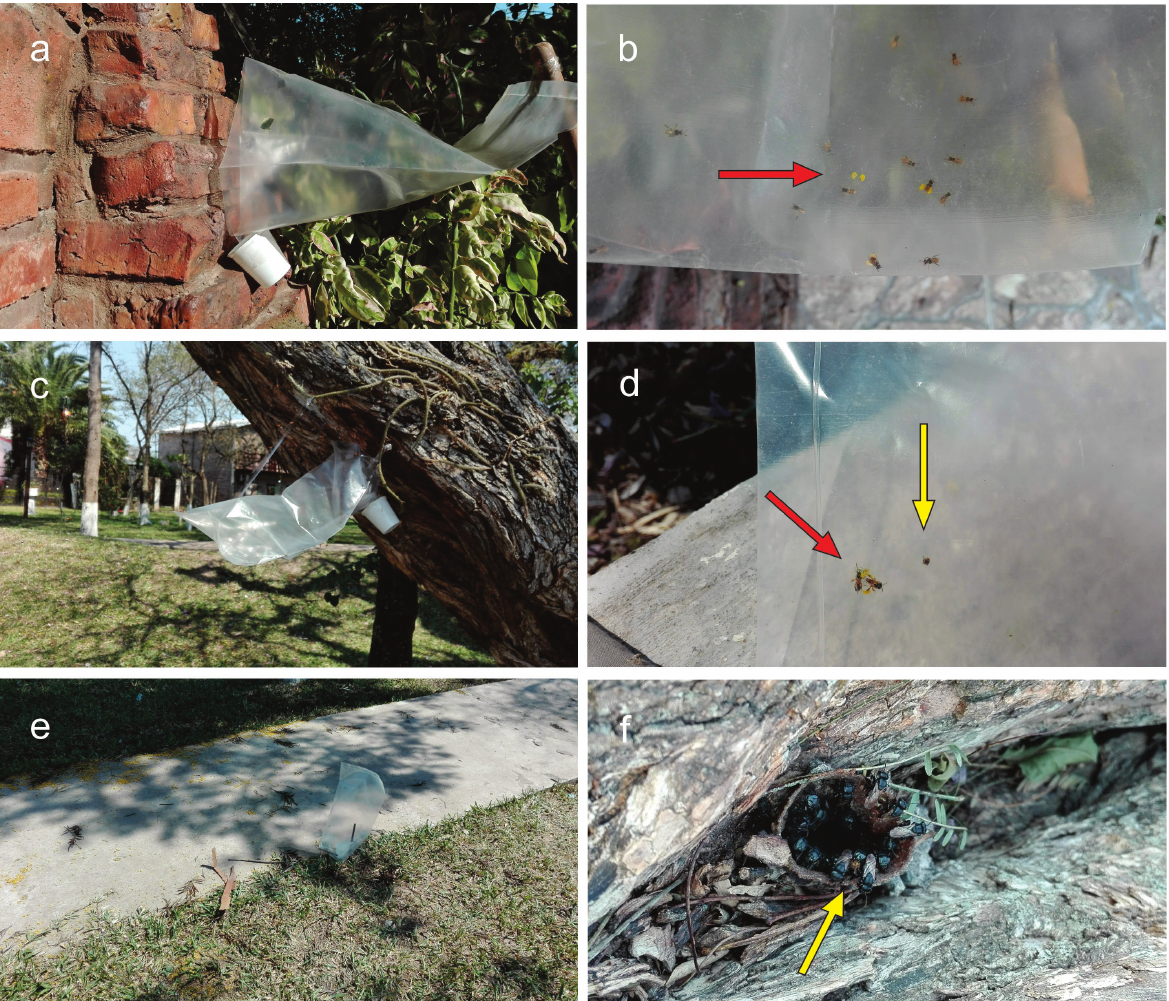
Figure 1 - Nylon bag used for sampling load and garbage pellets: a_from Plebeia catamarcensis (nesting in brick wall, horizontal tube); c_from Tetragonisca angustula fiebrigi (leaning tree trunk, horizontal tube); e_from Geotrigona argentina (nesting in the ground, horizontal soil surface, bees departing upwards). b_Pollen loads (red arrow) of P. catamarcensis trapped in the nylon bag; d_Pollen loads from incoming workers (red arrow) and garbage pellet from outgoing workers (yellow arrow) of T. angustula fiebrigi trapped in the nylon bag; f_Nest entrance from Scaptotrigona jujuyensis in leaning tree trunk. A garbage pellet carried in the mandible of a leaving worker can be seen (yellow